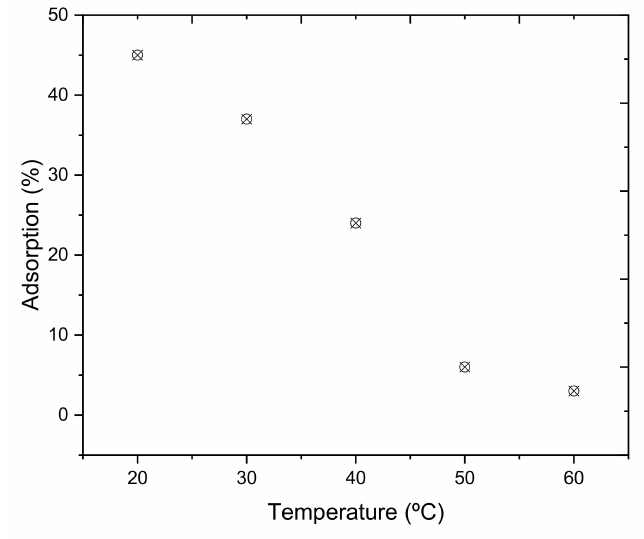
Figure 4. Cr(VI) adsorption at di ff erent temperatures. Aqueous phase: 0.01 g / L Cr(VI) at pH 3. Carbon dosage: 0.5 g / L. Time: 5 h. Stirring speed: 1000 min − 1